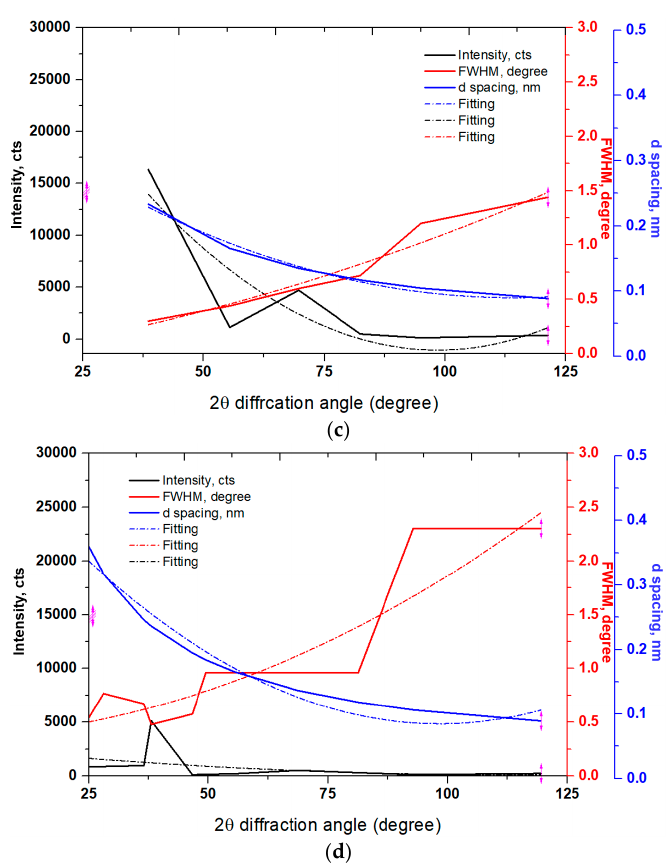
Figure 4. Variation in intensity, full width at half maximum (FWHM) and spacing of the untreated ( a ), UNSM-treated at RT ( b ) and LHT without ( c ) and with ( d ) UNSM treatment at 1000 °C specimens. Furthermore, the diffraction peaks of the UNSM-treated specimens at both RT and HT shifted to a lower diffraction angle (see Figure 5), which is an indicator of the induced compressive residual stress [40], while on the contrary, the diffraction peak of the LHT without UNSM treatment at 1000 °C specimen shifted to a higher diffraction angle. The presence of uniform compressive strain that was derived during grain size refinement process is responsible for the diffraction peak shift to a lower angle [41], while the diffraction peak shift to a higher angle is responsible for the tensile stress [42]. It is well established that the internal stresses, planar faults (stacking faults or twinning) are responsible for the changes in relative diffraction peaks (intensity, FWHM, and shift) of the metallic materials that are subjected to both S 2 PD and SPD processes [43,44].